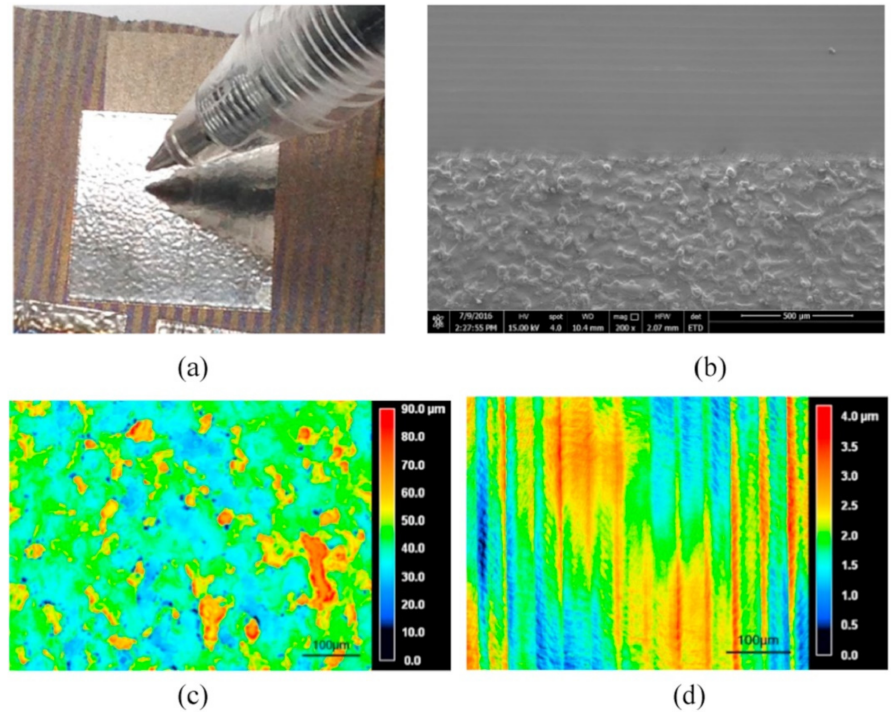
Figure 12. Effects of laser polishing on TC4 Ti alloy manufactured by laser AM. ( a ) Laser-polished region of the laser AM surface. ( b ) SEM micrograph of the boundary comparison between the original region and laser-polished region. ( c ) Topographic image from laser scanning confocal microscope of the original region. ( d ) Topographic image from laser scanning confocal microscope of the laser-polished region. (Reprinted with permission from ref. [117]. Copyright 2017